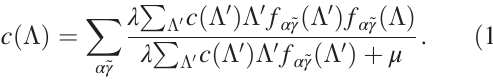
TABLE I. Structure and spectra of the normalized network of layers Φ ~ γ ~ average degree of each layer, h k l i , is the same, i.e., h k l i ¼ h k i , ∀ l .